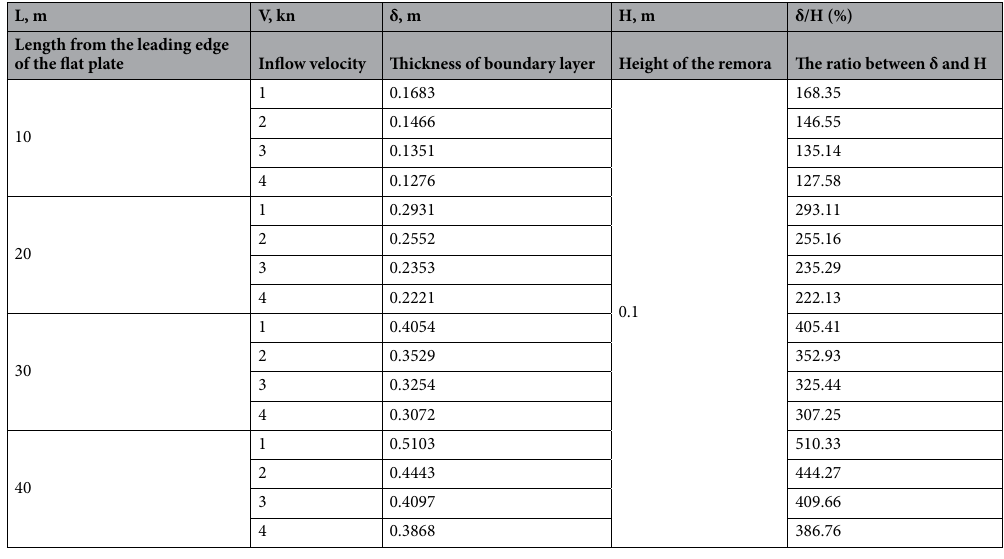
Table 4. Thickness of flat-plate boundary